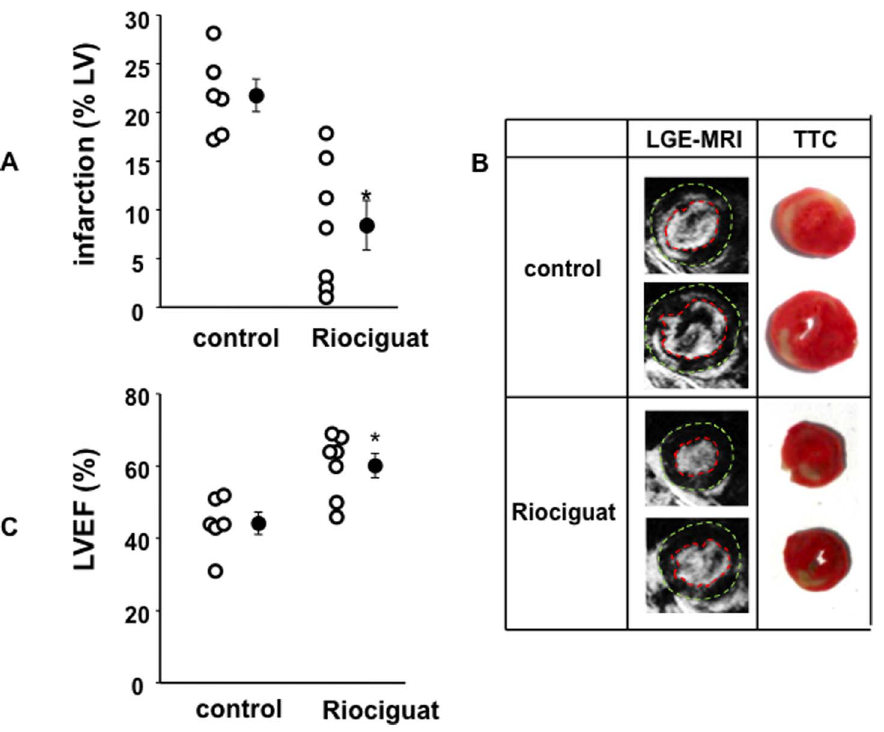
Figure 2. Infarct size assessment with LGE-MRI and effects of riociguat on left ventricular ejection fraction 24 h after myocardial infarction. (A) Infarct size was determined with LGE-MRI 24 h after the ischemic event showing that acute riociguat treatment markedly reduced infarct size. * p , 0.005. (B) There was a good correlation between infarct size assessment via histological TTC staining (representative images depictured on the right) and LGE-MRI (left). Epicardial and endocardial borders have been manually added for clarity. (C) Riociguat significantly increased LV ejection fraction compared to untreated control measured by MRI 24 h after the ischemic event. Open symbols represent individual experiment and closed symbols are means 6 SEM. * p ,